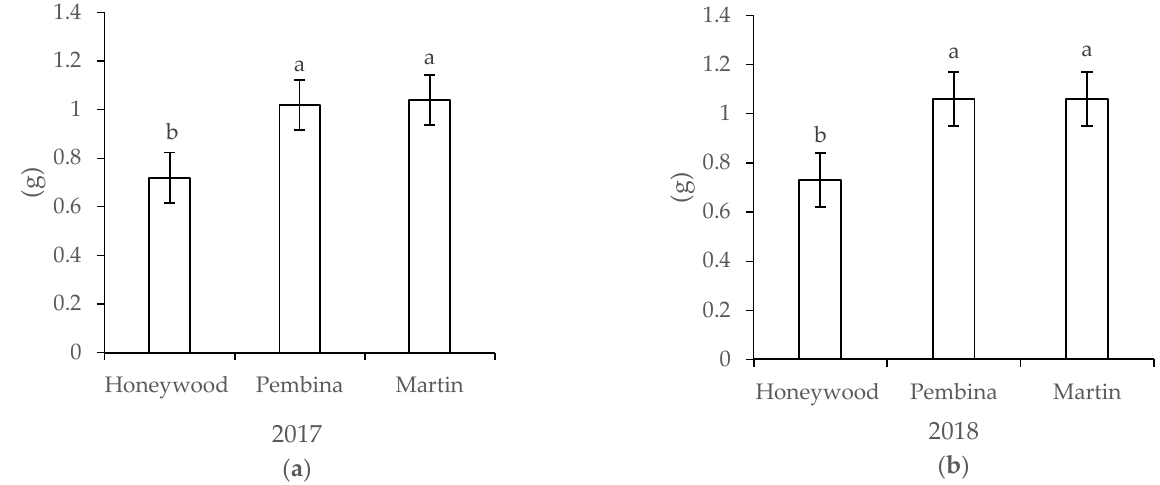
Figure 3. Fruit mass of the studied cultivars in ( a ) 2017 and ( b ) 2018. Values with different letters are significantly different within a year.